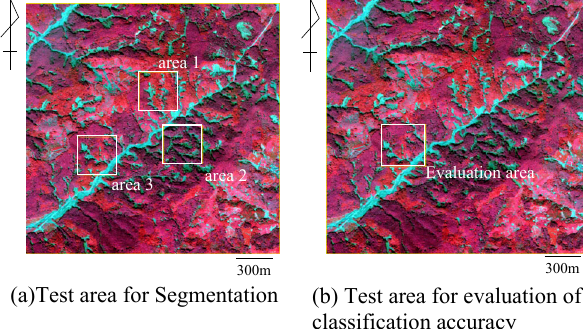
(a)Test area for Segmentation (b) Test area for evaluation Figure 3. Verification area for segmentation and classification accuracy